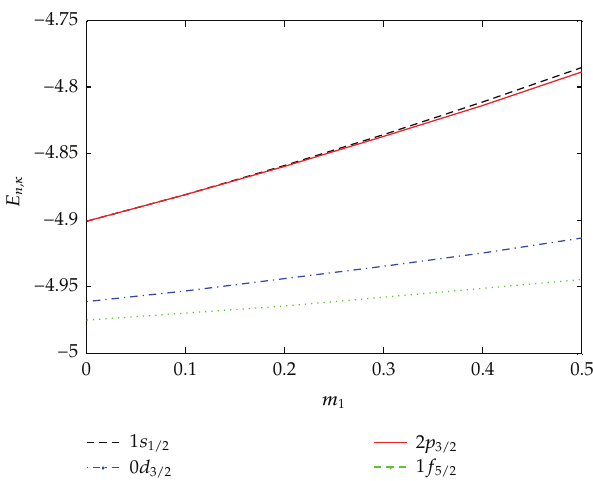
Figure 3: The variation of the energy levels as a function m 1 in the presence of pseudospin symmetry.